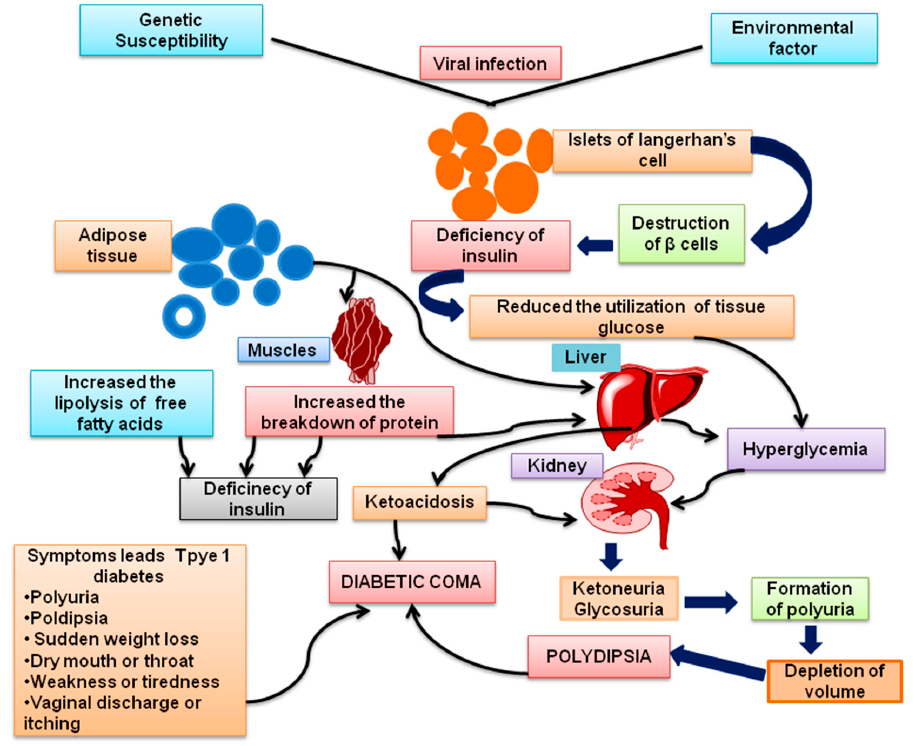
Figure 2. Pathophysiology of Type 1 Diabetes mellitus (T1DM).